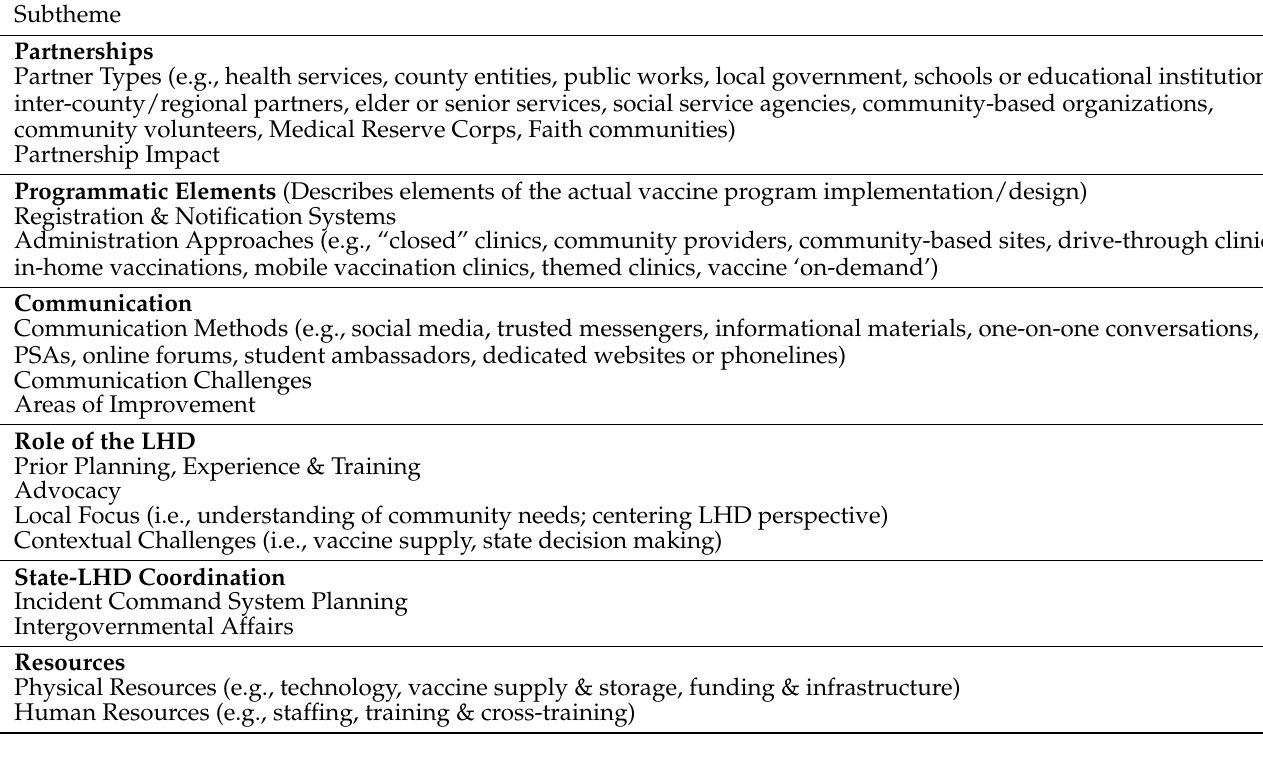
Table 2. Thematic Framework of Notable Themes across Phases of Data